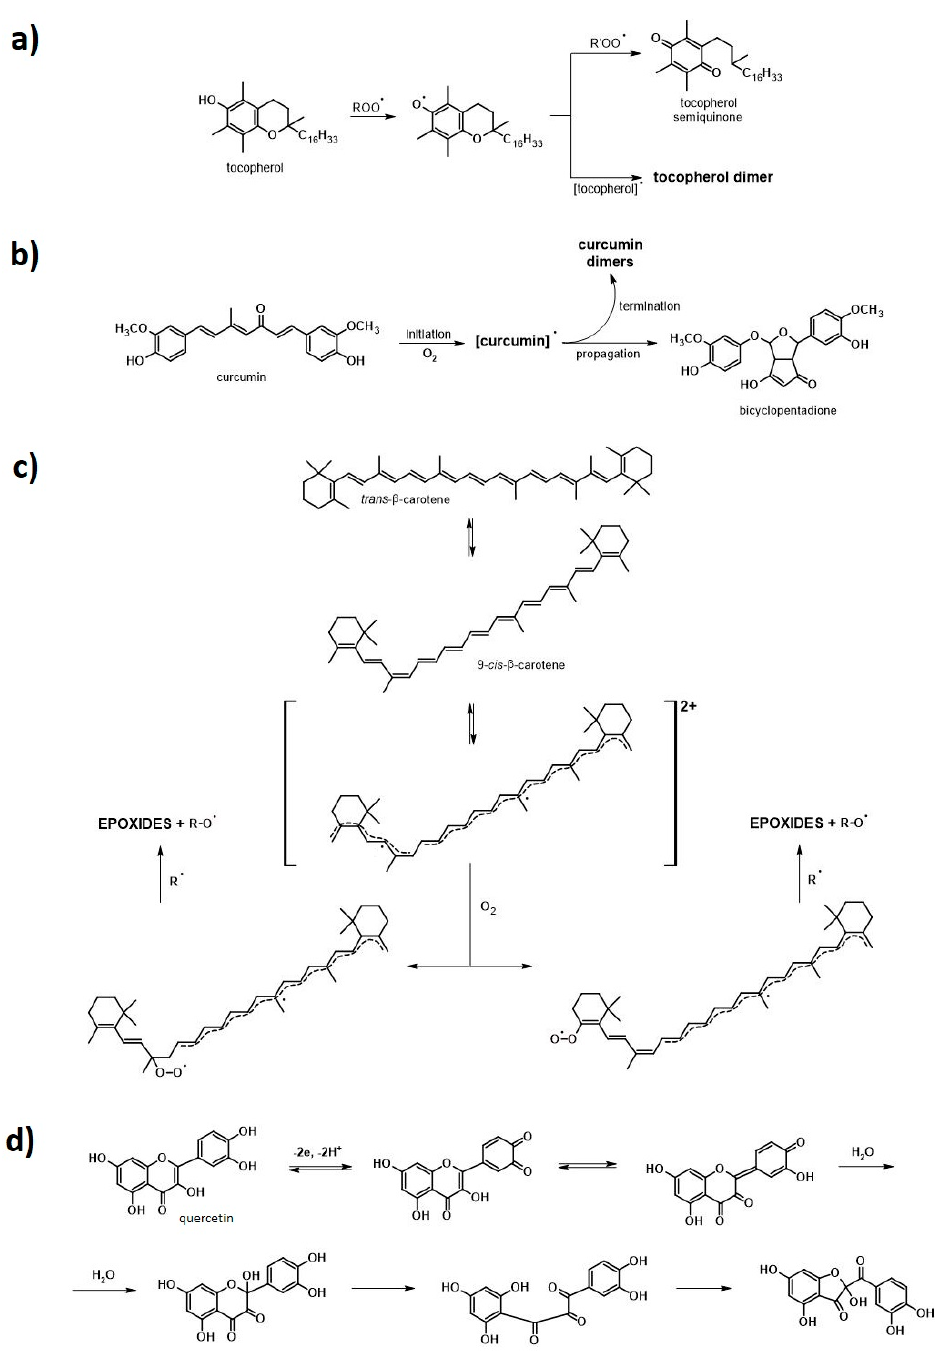
Figure 8. Possible mechanisms of free radical scavenging and oxidation behavior according to the available literature data: ( a ) δ -tocopherol ( δ -TF), ( b ) curcumin (CM), ( c ) β -carotene ( β -CT), ( d ) quercetin (QU).